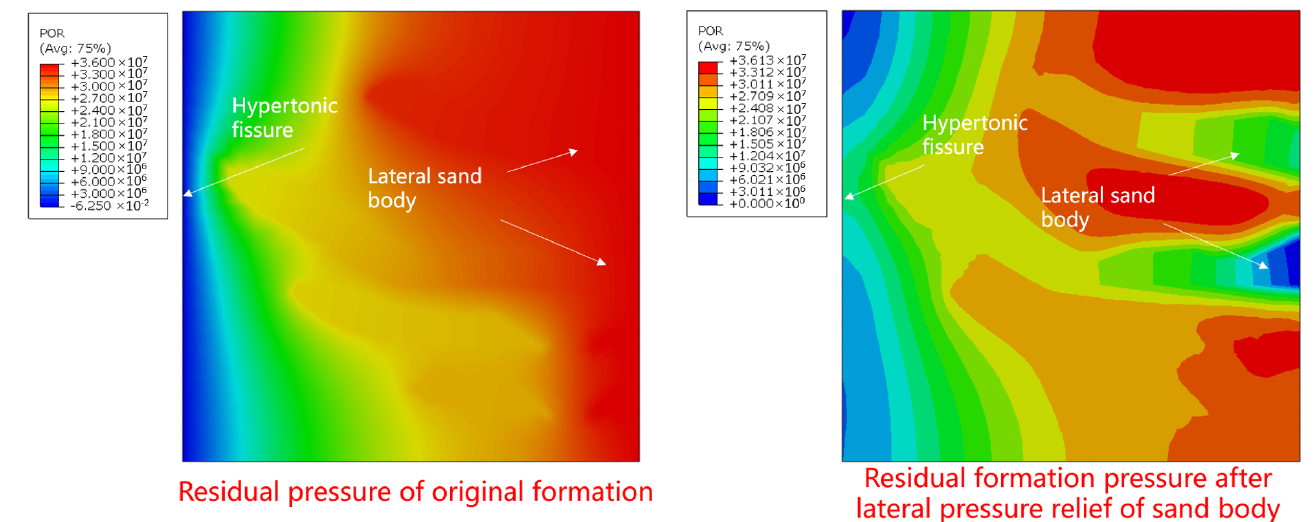
Figure 14. Formation pressure changes before and after the opening of diapir induced high perme- ability fractures.